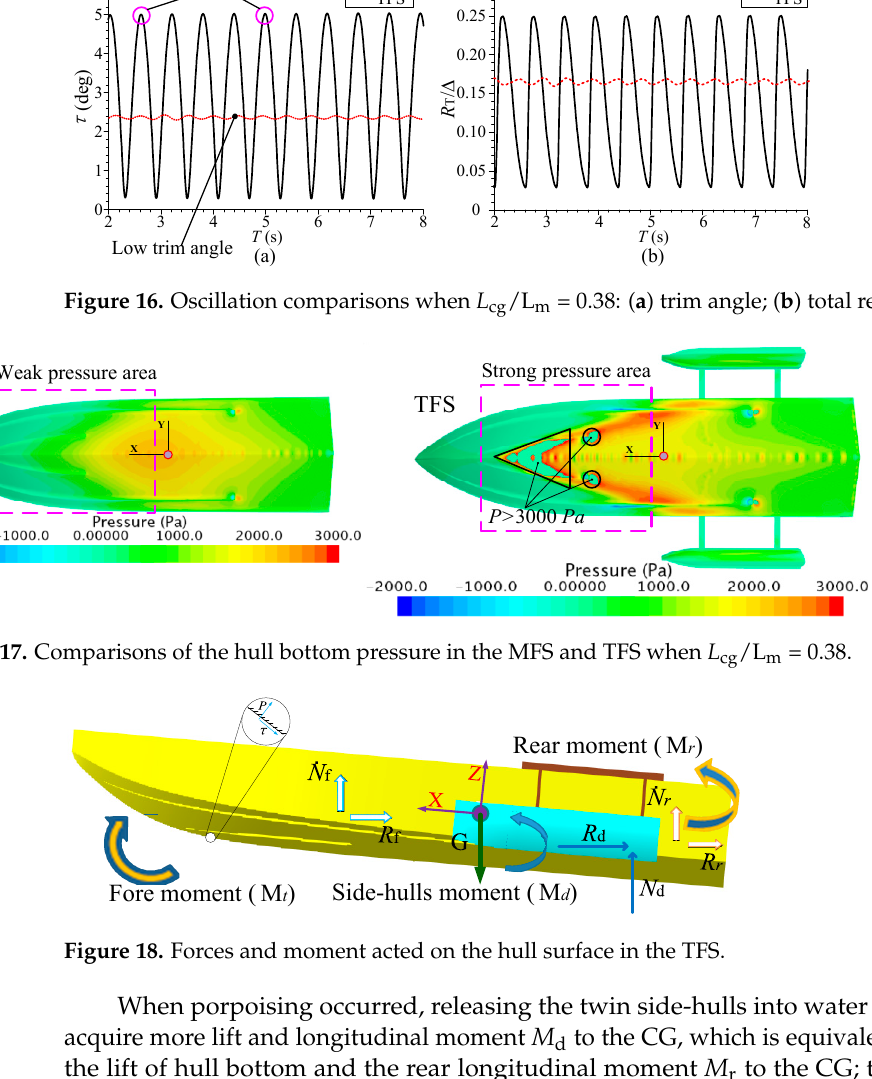
Figure 19. Why porpoising occurs.